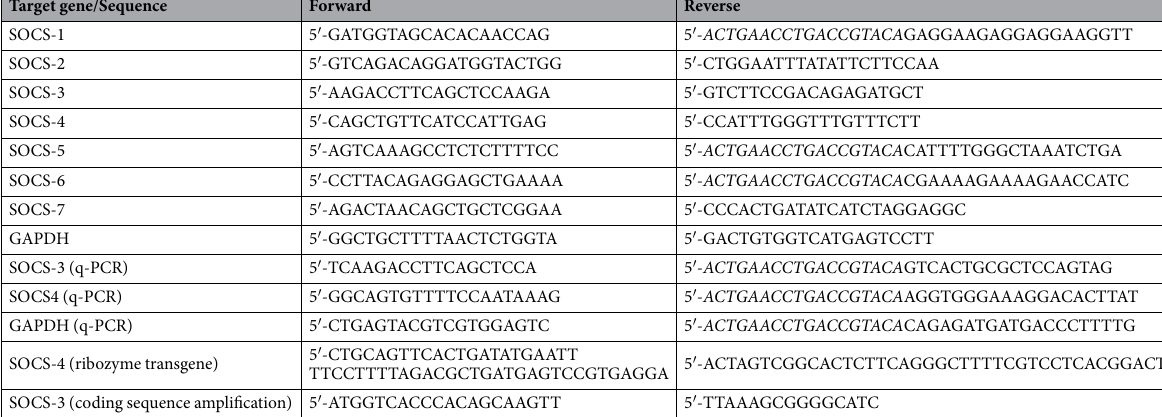
Table 1. Primers/sequences used in the study. Z Sequence represented by ‘ ACTGAACCTGACCGTACA